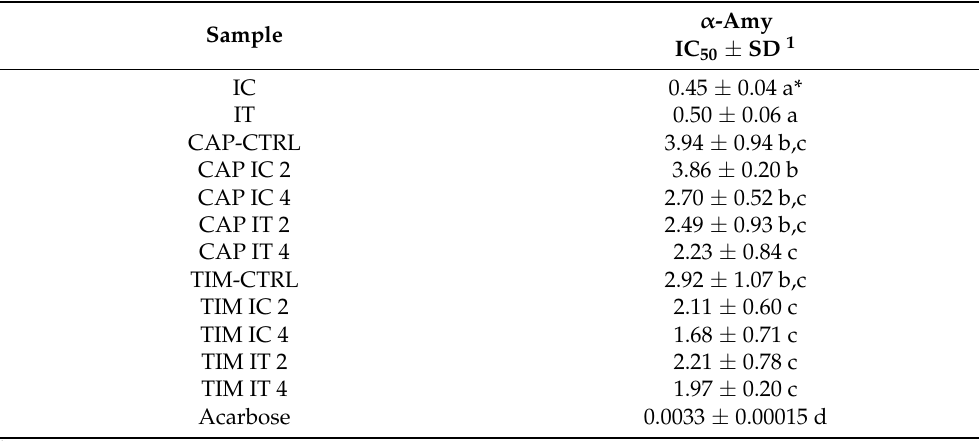
Table 8. The α -amylase inhibitory activity of spaghetti produced with cv Senatore Cappelli flour (CAP) and cv Timilia (TIM) and spaghetti enriched with inulin samples (IC and IT).